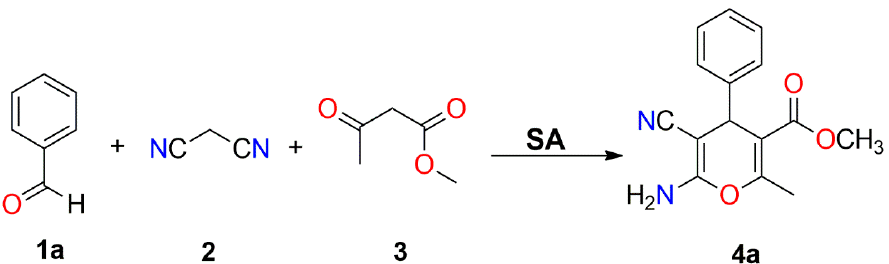
Figure 2. 1 H NMR spectrum of Na-alginate (SA) from Sargassum muticum.